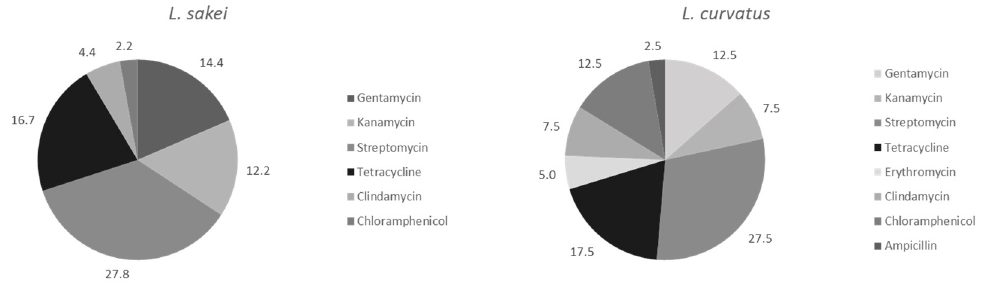
Figure 2. Relative abundance of resistant biotypes for each species and antibiotics tested.